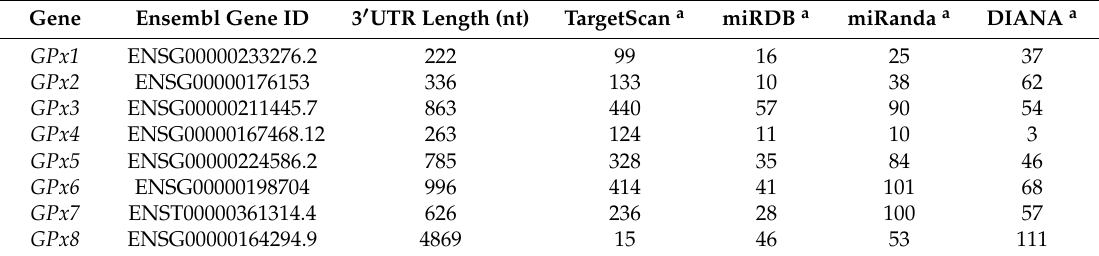
Table 1. In silico prediction of miRNAs targeting 3 (cid:48) UTR of GPxs employing four different algorithms.